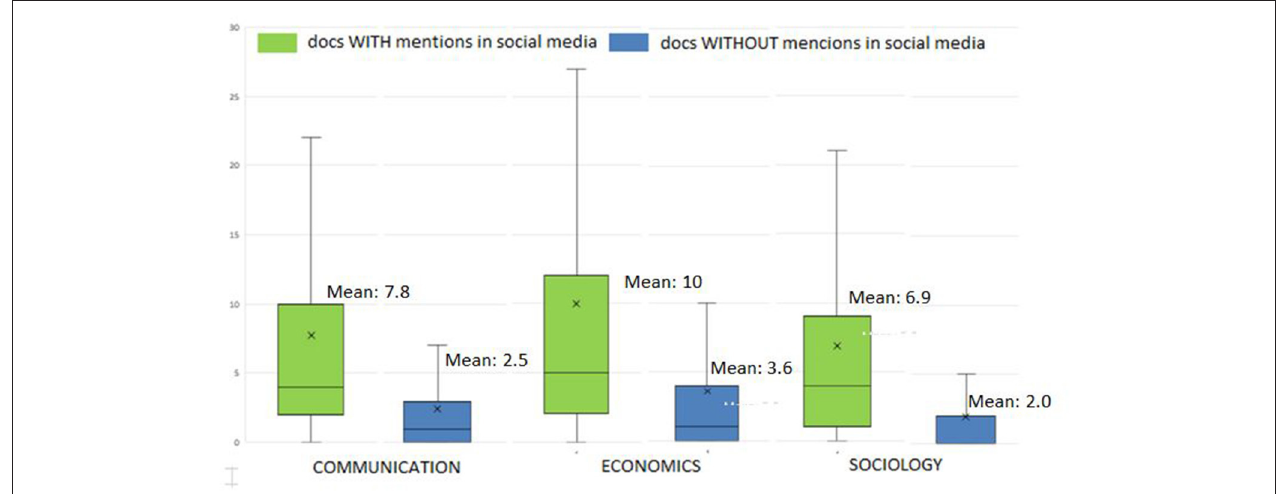
FIGURE 7 | Citations per paper with vs. those without mentions in the social media by discipline.